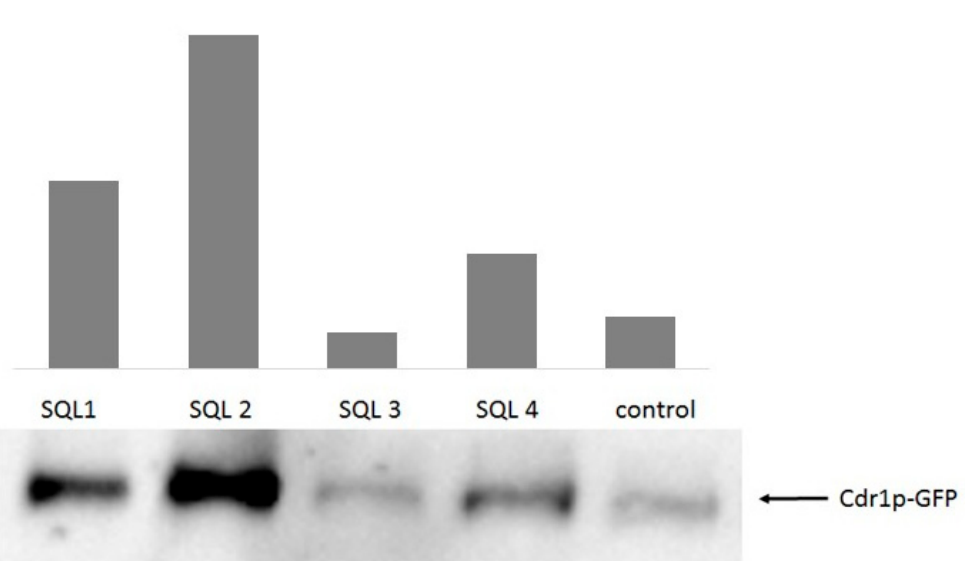
Figure 6. Cdr1p-GFP protein levels in crude protein extracts of the cells after treatment with styrylquinolines (½MIC) as was evidenced by the anti-GFP Western blot ( n = 4); DMSO-treated C. albicans cells were used as the control.